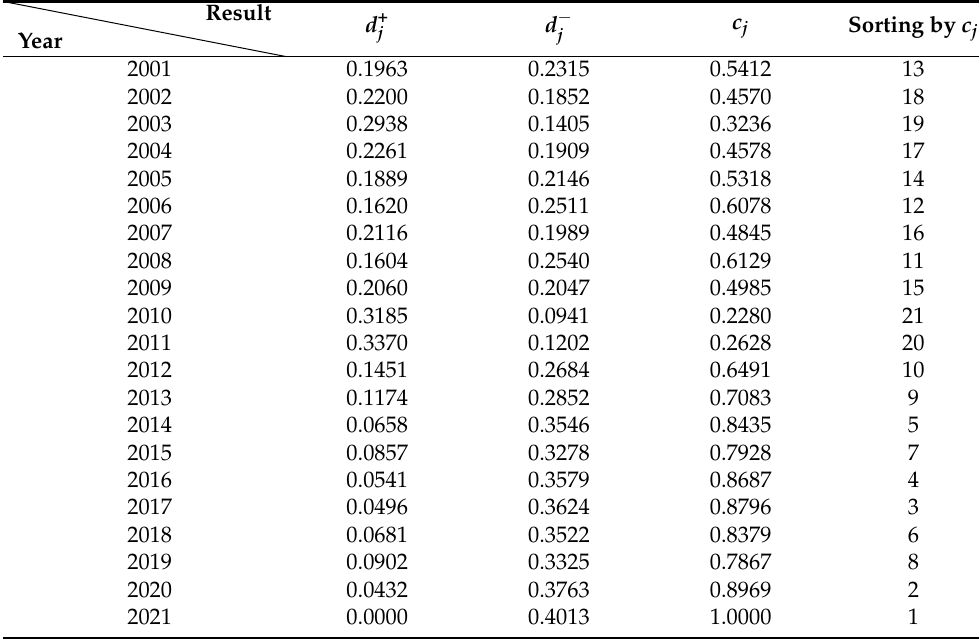
Table 3. Ranking of the comprehensive risk evaluation index C j .